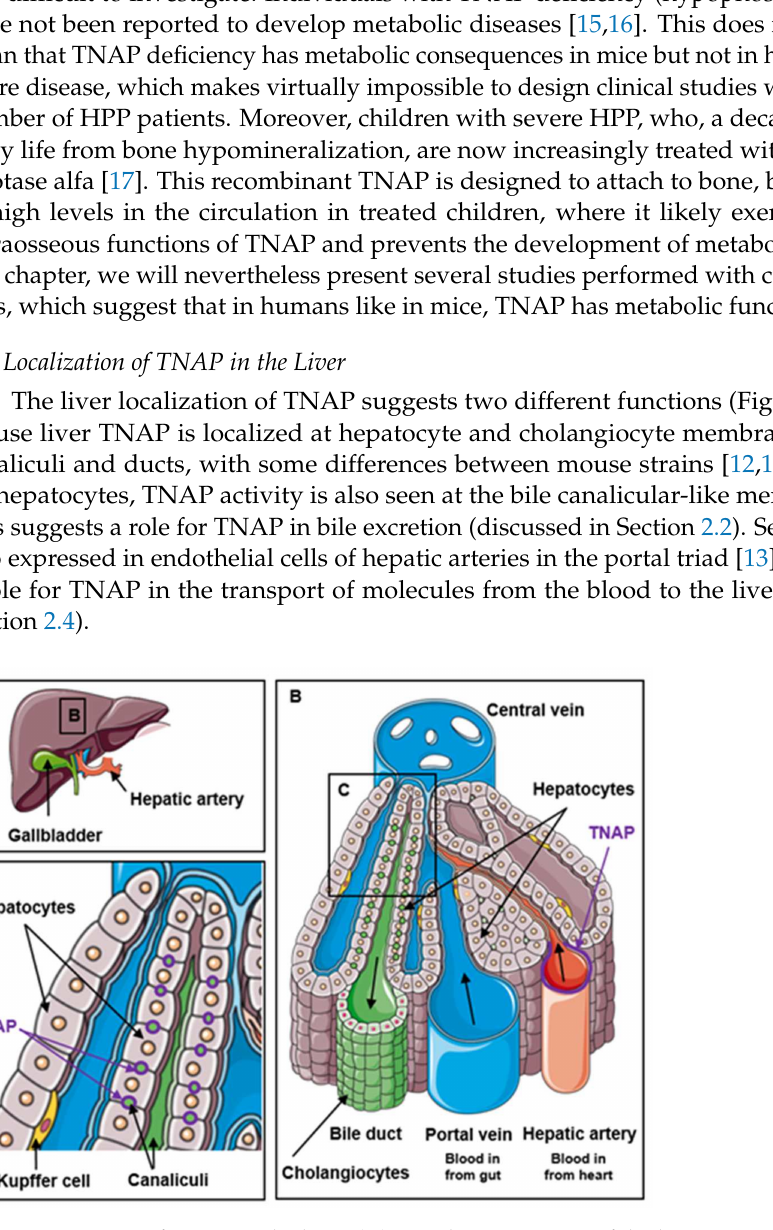
Figure 1. Location of TNAP in the liver. ( A ) Rough presentation of the liver structure indicating the region presented in ( B ). ( B ) Typical organization of hepatocytes and cholangiocytes delimitating bile ducts and liver vascularization showing TNAP location in hepatic artery. ( C ) Detail of ( B ) showing TNAP location in hepatocyte membranes facing bile